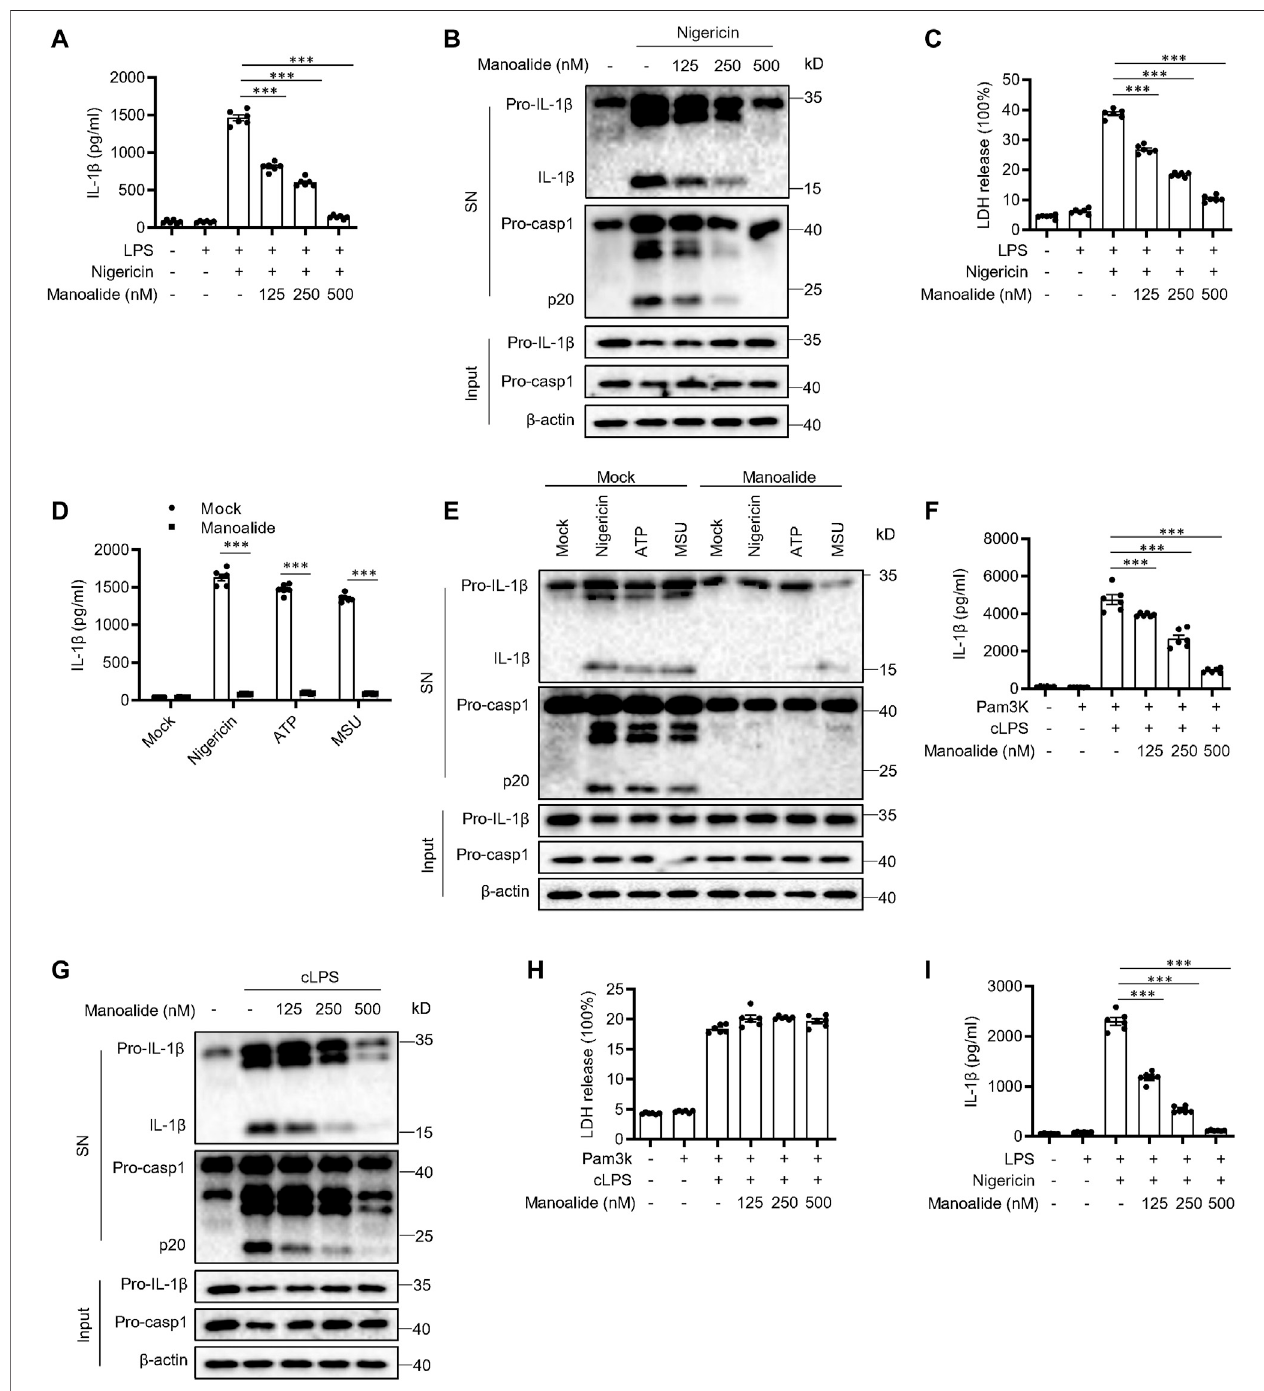
FIGURE1| ManoalideinhibitstheNLRP3in fl ammasomeactivation. (A-C) BMDMswereprimedwithLPSfor3 handthenwerepretreatedwith125,250,500 nM manoalide before stimulation with nigericin for 15 min (A) ELISA of mature IL-1 β in supernatant from BMDMs. (B) Western blots analysis of supernatant (SN) and cell lysates (Input) from BMDMs. (C) LDH release in the supernatant from BMDMs. (D) ELISA of mature IL-1 β and (E) Western blots of SN and Input from BMDMs primed withLPSandstimulated withnigericin,MSUandATPwithorwithout500 nMmanoalide. (F-H) BMDMswereprimedwithPam3Kfor3 handthenwerepretreated with 125, 250, 500 nM manoalide before stimulation with cytosolic LPS (cLPS) for 16 h. (F) Production of mature IL-1 β in supernatant from BMDMs. (G) Western blots analysisofsupernatant (SN) andcelllysates (Input) fromBMDMs. (H) LDHrelease inthesupernatantfromBMDMs. (I) ELISAofmaturehumanIL-1 β insupernatant from PBMCs primed with LPS for 3 h and then were pretreated with 125, 250, 500 nM manoalide before stimulation with nigericin. Data are derived from three independent experiments (A,C,D,F,H,I) anddisplayedasmeanandSEM( n =6)orrepresentthreeindependentexperiments (B,E,G) .Statisticallysigni fi cantdifferencewascalculated by unpaired Student ’ s t-test: *** p < 0.001.